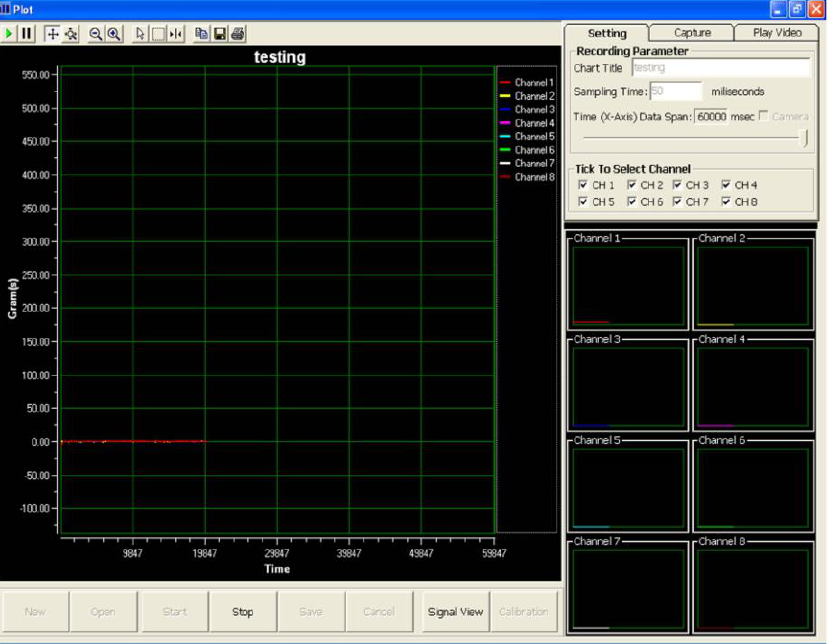
Figure 3. Graphical user interface of the data acquisition system.